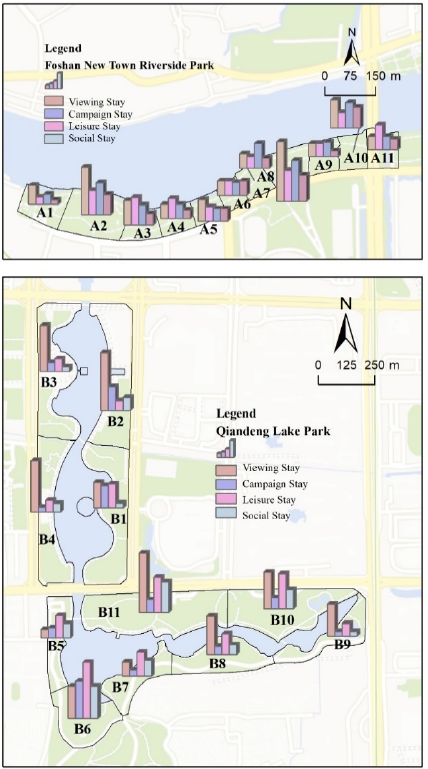
Figure 6. Vitality values of the different activity types in the waterfront